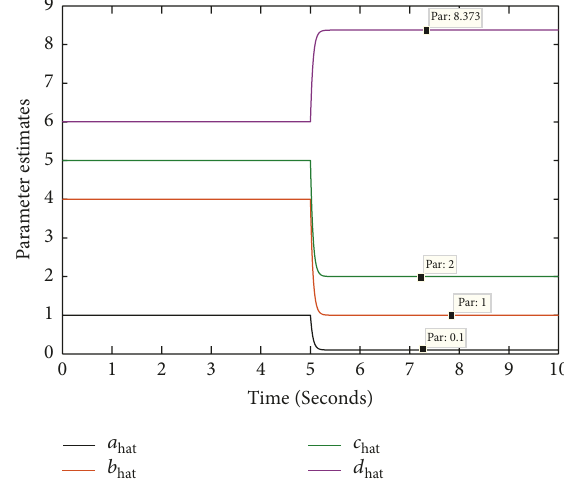
Figure 18: Estimated parameters of FOPF system (controller in action at 𝑡 = 5